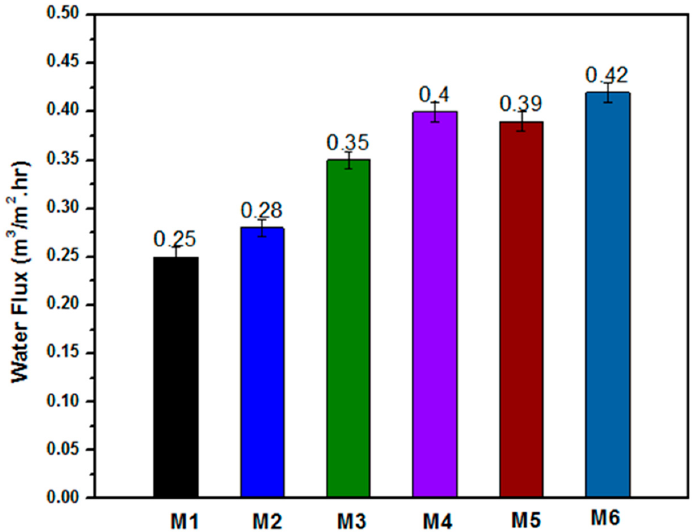
Figure 10. Water flux of the different membranes ( M1 to M6 ); results show water flux increase in treatment membranes.